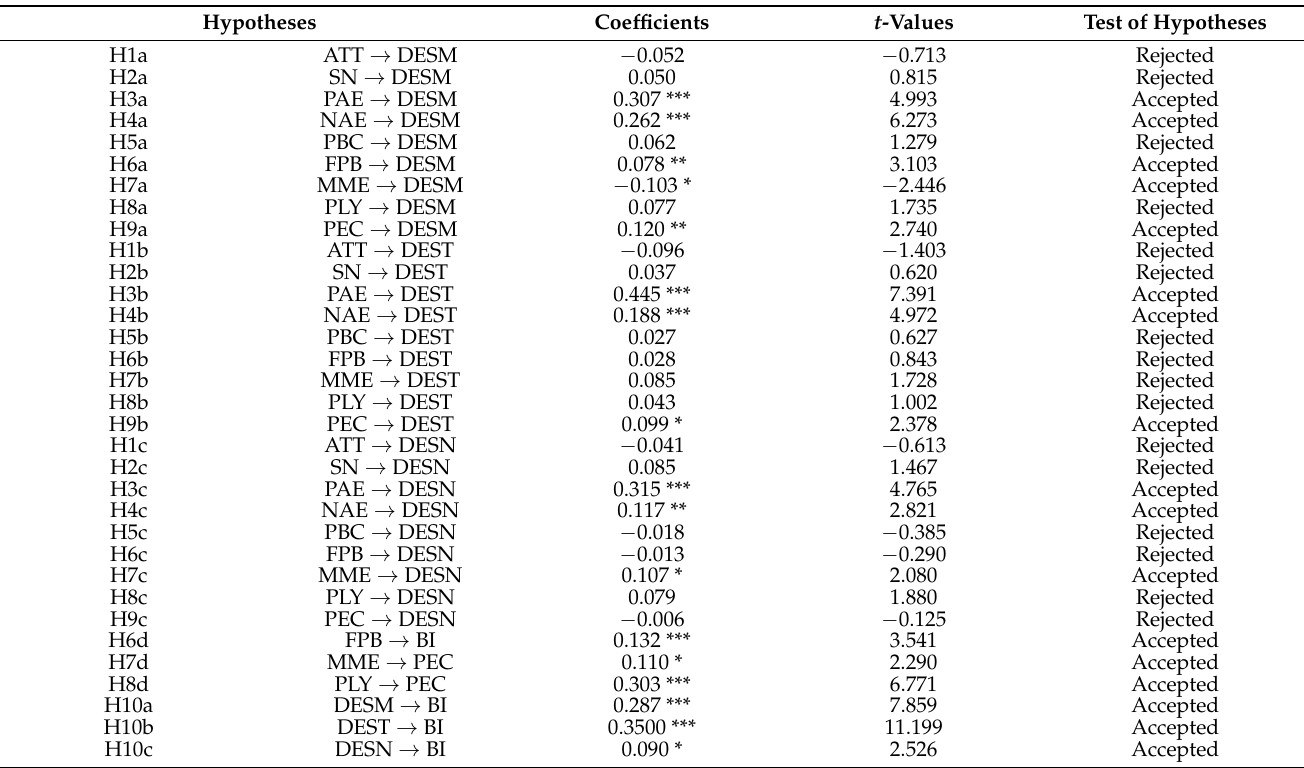
Table 5. Standardized parameter estimates of structural model (N =